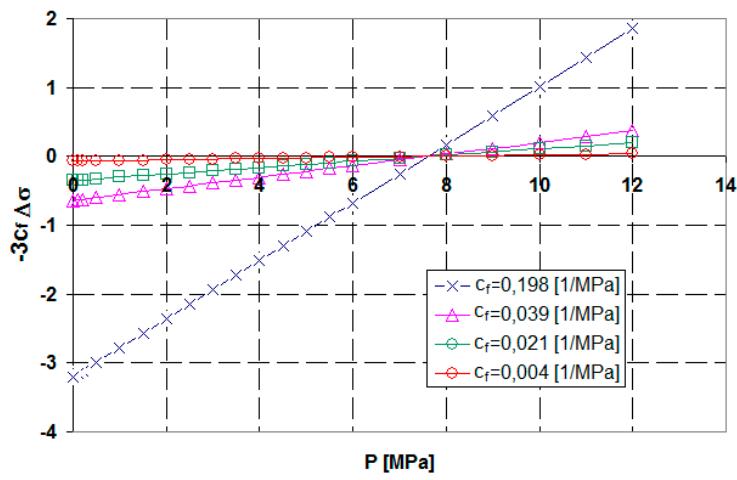
Figure 7. Deformations in Mannville Group coal produced solely by the geomechanical action of the pore pressure based on the Cui and Bustin model.